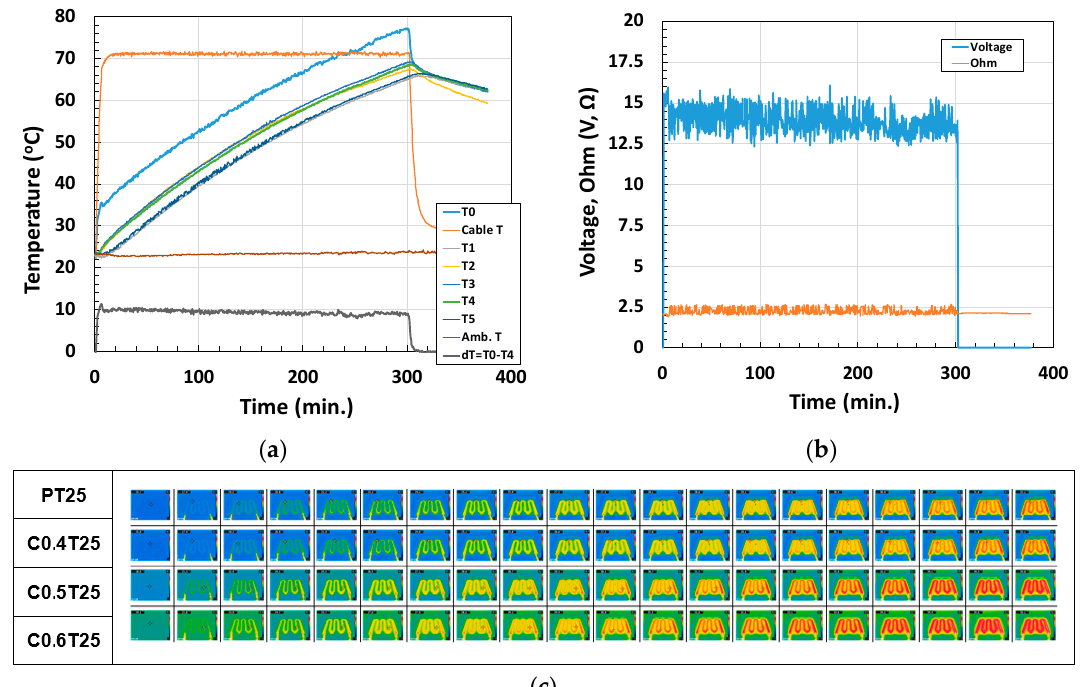
Figure 2. Changes in temperature: ( a ) time-dependent temperature at T 0 – T 4 , and at the heat source (cable temperature), and the ambient temperature and temperature gradient, ( b ) voltage and resistance of the cable while heat was applied, and ( c ) temperature distribution on the top surface measured using an infrared camera (every 20 min over the 6 h heating process). C0.4, C0.5, and C0.6: mortar composite with 0.4 wt %, 0.5 wt %, and 0.6 wt % of pitch-based carbon fiber, T25: 25 mm specimen thickness.